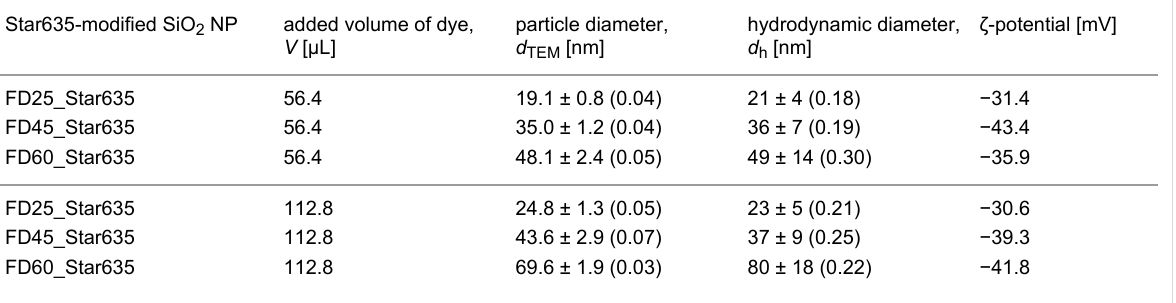
Table 4: Overview of the physical particle attributes of Star635–CS-modified silica nanoparticles using different dye concentrations during the synthe- sis. Numbers in brackets indicate the size dispersity p . Star635-modified SiO 2